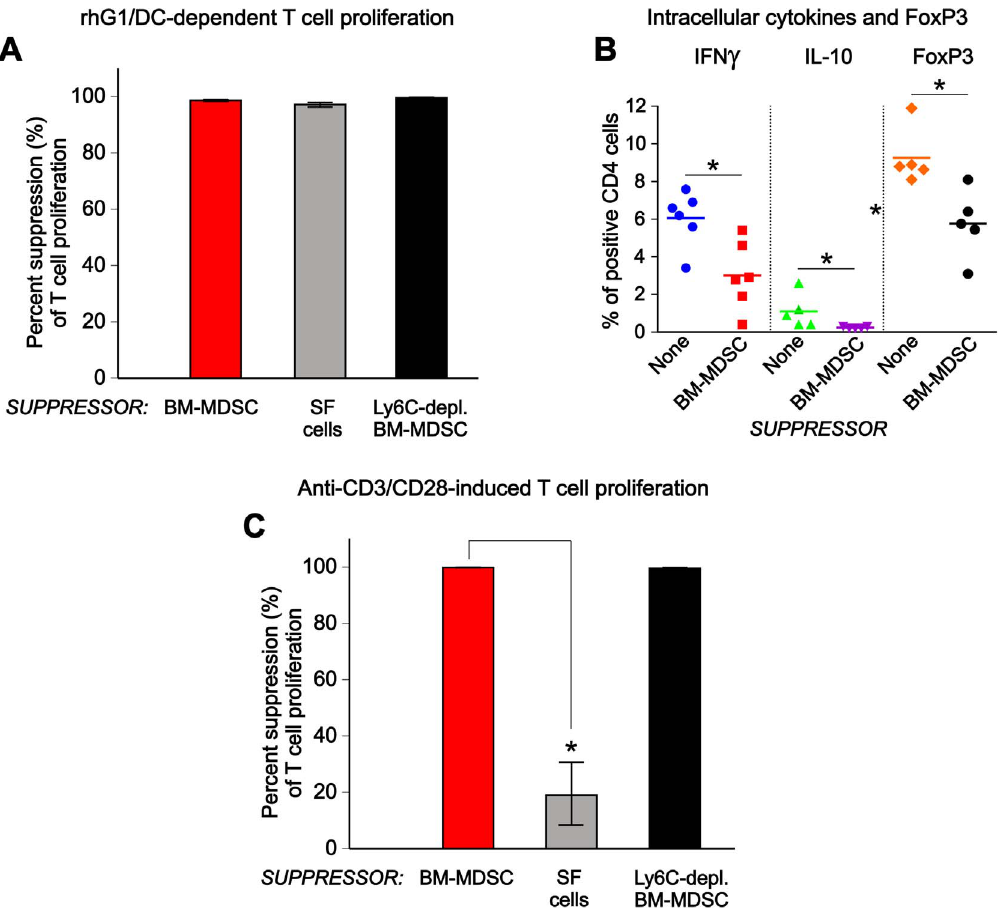
Figure 2. Suppression of antigen (Ag)-specific and non-specific T-cell responses by BM-MDSCs. ( A ) T cells, purified from the spleens of mice expressing a PG-specific T cell receptor transgene (PG-TCR-Tg) were cultured for 5 days with dendritic cells (DCs) loaded with recombinant G1 domain of human PG (rhG1) in the absence or presence of the following ‘‘suppressors’’: BM-MDSCs (red bar), arthritic SF cells (gray bar), or Ly6C hi (monocytic) cell-depleted BM-MDSCs (black bar). The ability of suppressors to inhibit Ag (rhG1)-specific T-cell proliferation (which is also dependent on Ag presentation by DCs) was assessed on the basis of inhibition of [ 3 H]thymidine incorporation by the T cells. Percent suppression was calculated as described in the Methods. All suppressors exhibited robust inhibition of T-cell proliferation. The results shown are from 5 independent experiments. ( B ) T cells from PG-TCR-Tg mice were cultured for 2 days with rhG1-loaded DCs and BM-MDSCs as described for panel A. The percent of CD4 + T cells containing IFN c , IL-10, or FoxP3 (CD4 + CD25 + FoxP3 + T regulatory cells, Tregs) was determined by flow cytometry. The results shown are the individual values (n=5–6) and the means. On average, the percentages of IFN c + cells, IL-10 + cells, and Tregs were lower in the presence of BM- MDSCs (*p , 0.001, 0.001, and 0.05, respectively; Mann-Whitney U test) than in their absence (None). ( C ) T cells from PG-TCR-Tg mice were cultured in anti-CD3/CD28-coated plates for 4 days in the absence or presence of the listed suppressors. Percent suppression was calculated and results expressed as described for panel A. Non-depleted BM-MDSCs and BM-MDSCs depleted in Ly6C hi cells were equally potent in suppressing anti-CD3/ CD28-induced T-cell proliferation, while arthritic SF cells exhibited much weaker inhibition (*p , 0.01, n=5; Kruskal-Wallis test followed by Dunn’s multiple comparisons test) in this induction